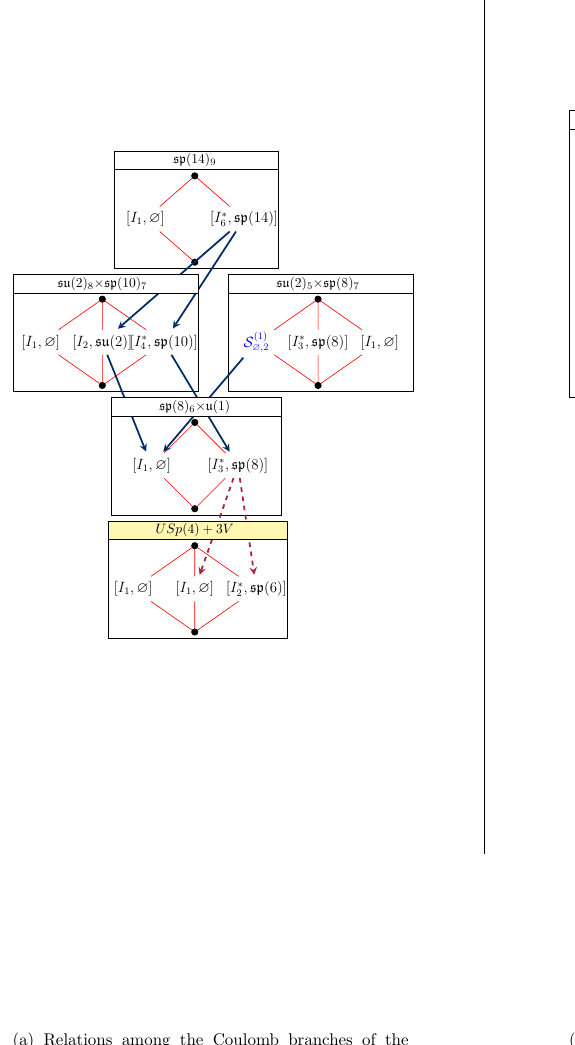
(a) Relations among the Coulomb branches of the sp (14) series. Figure 8 . Coulomb ( a ) and Higgs branch ( b ) analysis of the mass deformations among the entries of the sp (14)